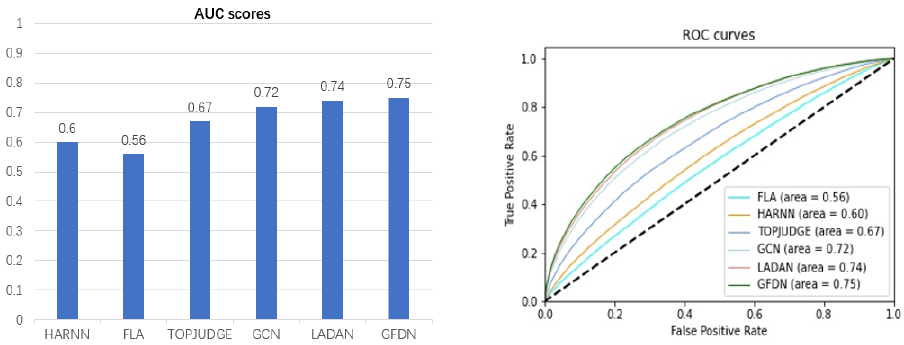
Figure 5. AUC scores and ROC curves of several models on CAIL-big.